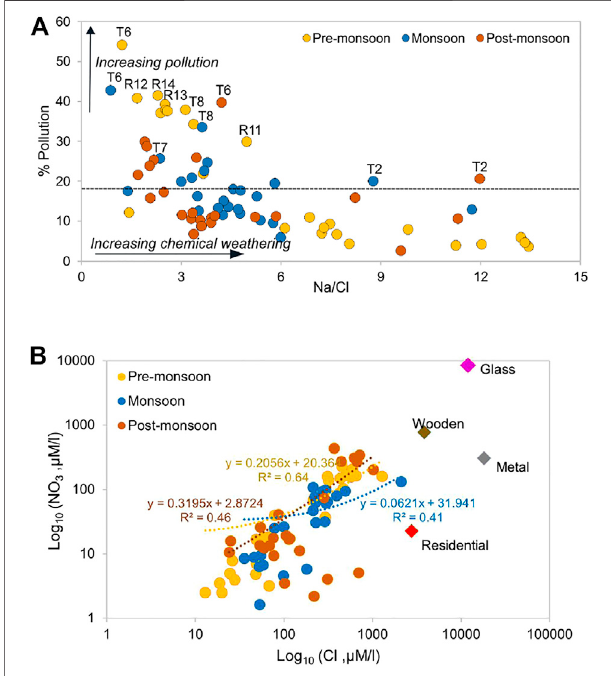
FIGURE 10 | (A) Pollution percentage versus Na/Cl showing high pollution in the downstream tributaries (dashed line indicate median value of fl oodplain samples), and (B) Cl versus NO 3 , data of urban sources and industries were adapted from the Joint Inspection Report, National Green Tribunal Report,